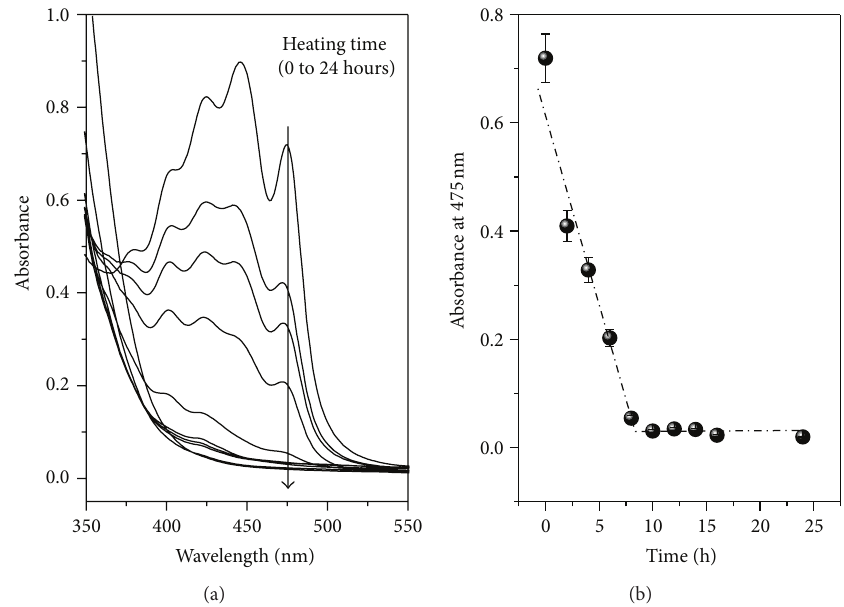
0.00.20.40.60.81.0